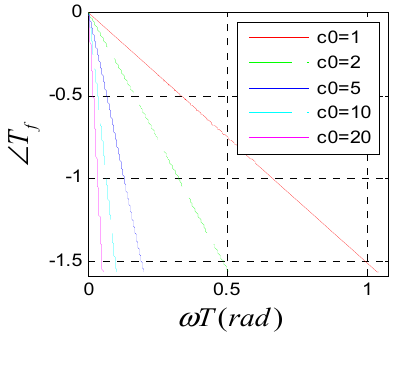
Figure 13. Phase-frequency characteristic of Equation (31).